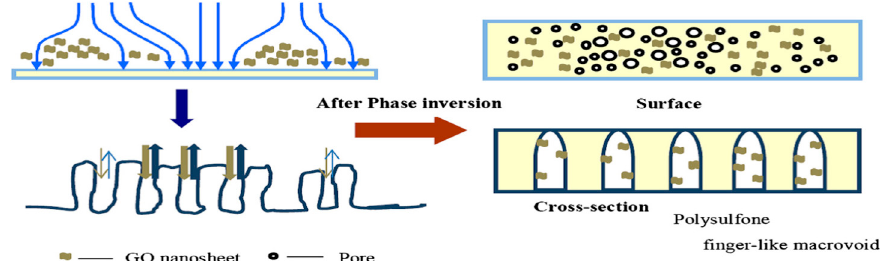
Figure 12. Schematic of the influence of graphene oxide (GO) nanosheets on phase inversion process. (Reproduced with permission after [92]).